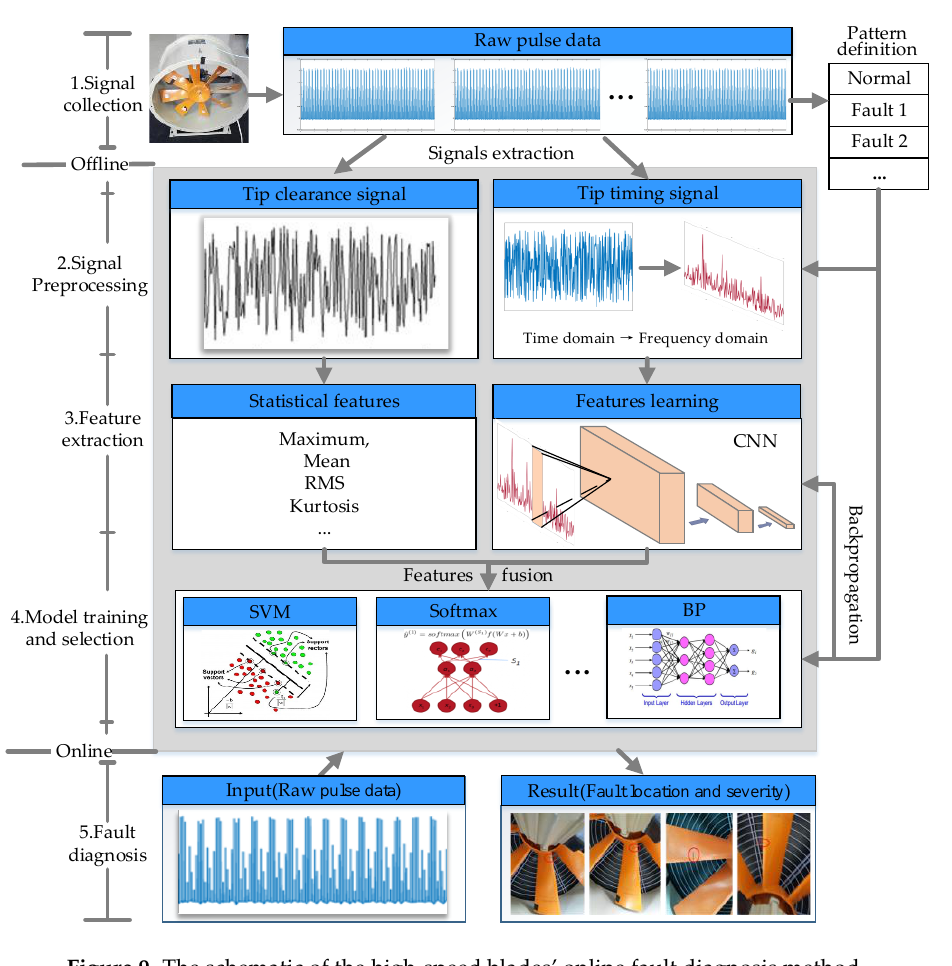
Figure 9. The schematic of the high-speed blades’ online fault diagnosis method.